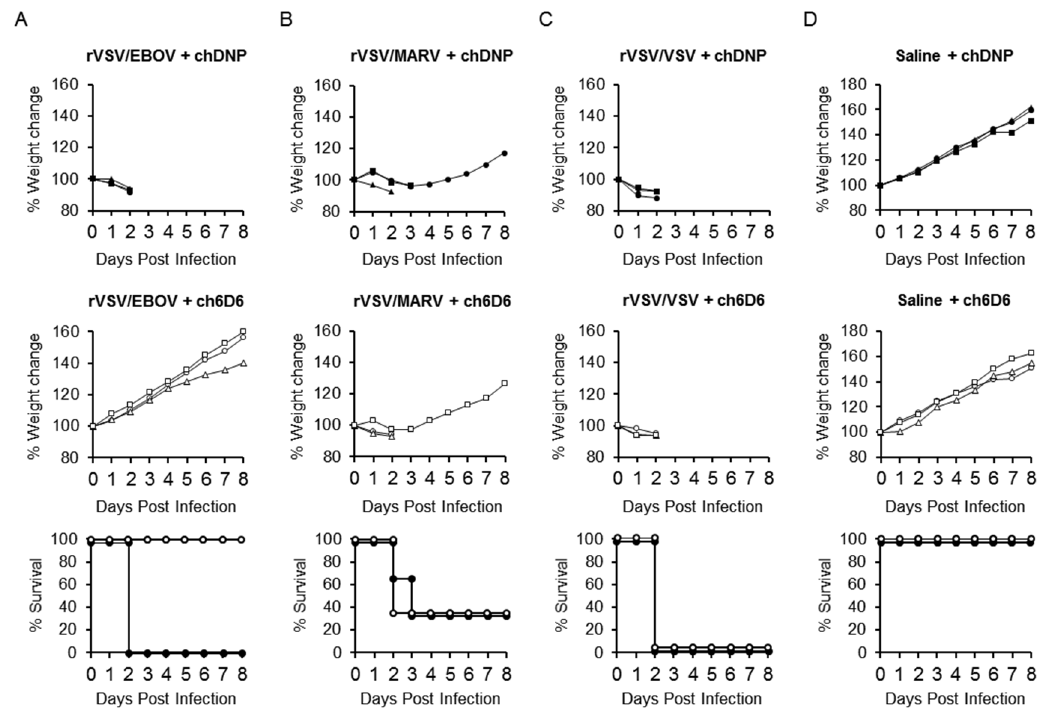
Figure 7. Therapeutic effect of post-exposure treatment with the neutralizing antibody in rVSV / EBOV-infected hamsters. Three hamsters in each group were treated i.p. with 100 µ g of MAb ch6D6 or negative control MAb chDNP one hour after ( A ) rVSV / EBOV, ( B ) rVSV / MARV, or ( C ) rVSV / VSV i.p. challenge (10 7 PFU), or ( D ) treated with saline alone. Symbols represent percentages of weight for each hamster (upper and middle panels). Open and solid symbols represent survival curves of 6D6- and chDNP-treated animals, respectively (lower panel).